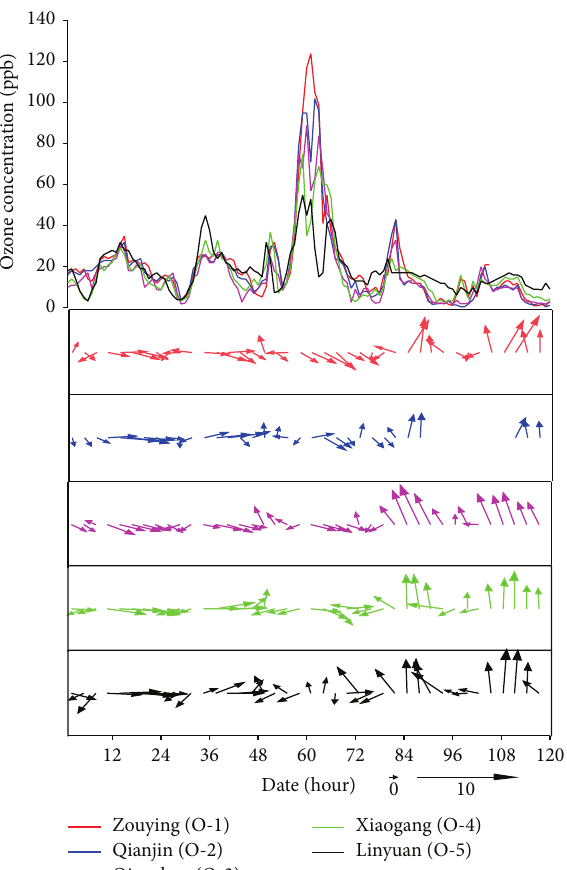
Figure 4: Observed O 3 concentrations and wind field for ocean group(Ogroup)ambientairqualitymonitoringstationsduringJune 28 and July 2, 2013.